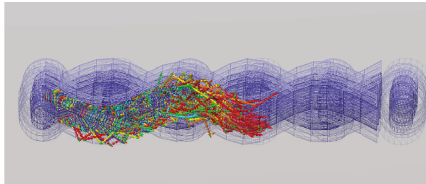
Figure 12: Example of ray propagation in a virtual POF-inserted plain weave fabric.